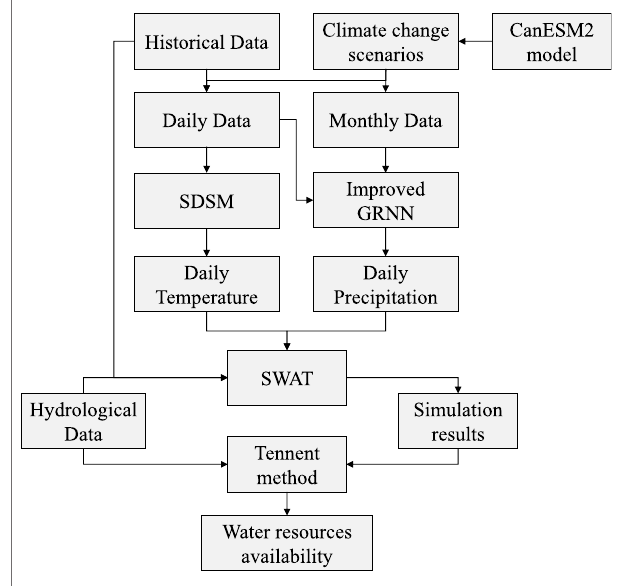
FIGURE 1 | The framework of evaluation method of available water